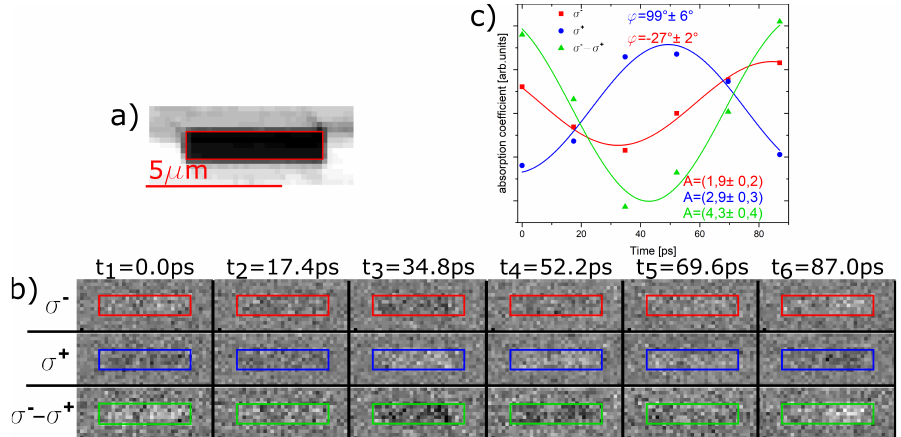
Figure 4. ( a ) chemical contrast picture of the Py stripe. In ( b ), two measurements of the dynamic magnetic contrast with different X-ray polarization taken at the Ni- L 3 -edge are shown as well as the difference between the two measurements; ( c ) shows the average transmission intensity of the X-rays through the stripe sample for the three cases shown in ( b ). The averaged data was fitted with a microwave frequency of